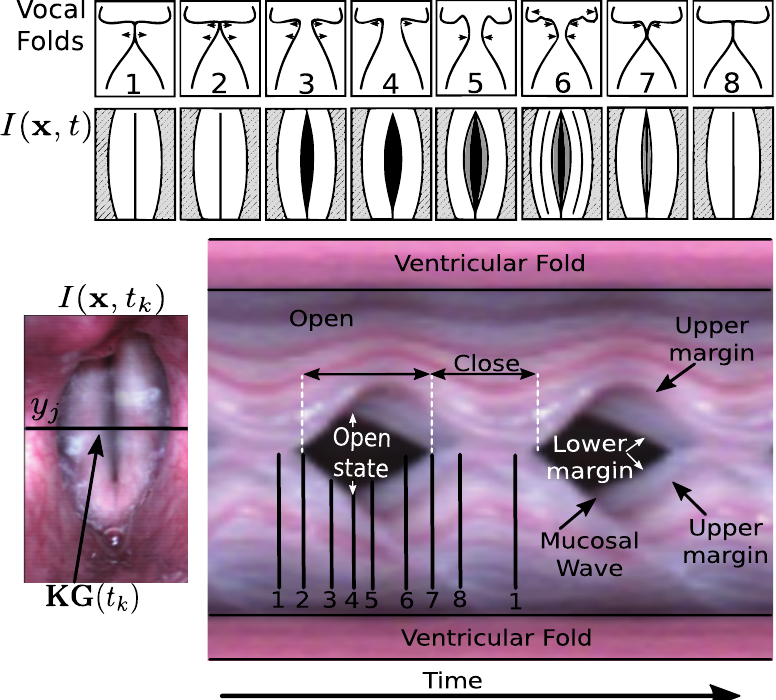
Figure 10. Schematical drawing of the successive phases of a glottal cycle in three views. First row: frontal section of the vocal folds. Second row: laryngoscopy (top view of the vocal folds). Third row: DKG at the line y j . Adapted from